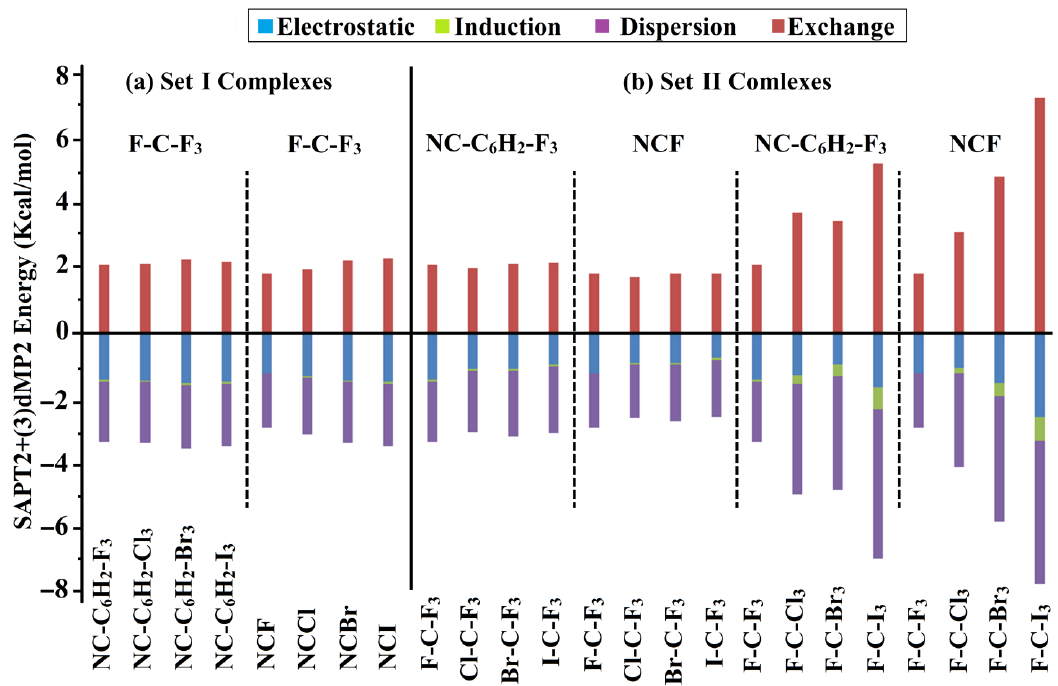
Figure 7. Bar chart illustrating the attractive forces against the repulsive ones of total SAPT2+(3)dMP2 energy for (a) Set I and (b) II complexes.